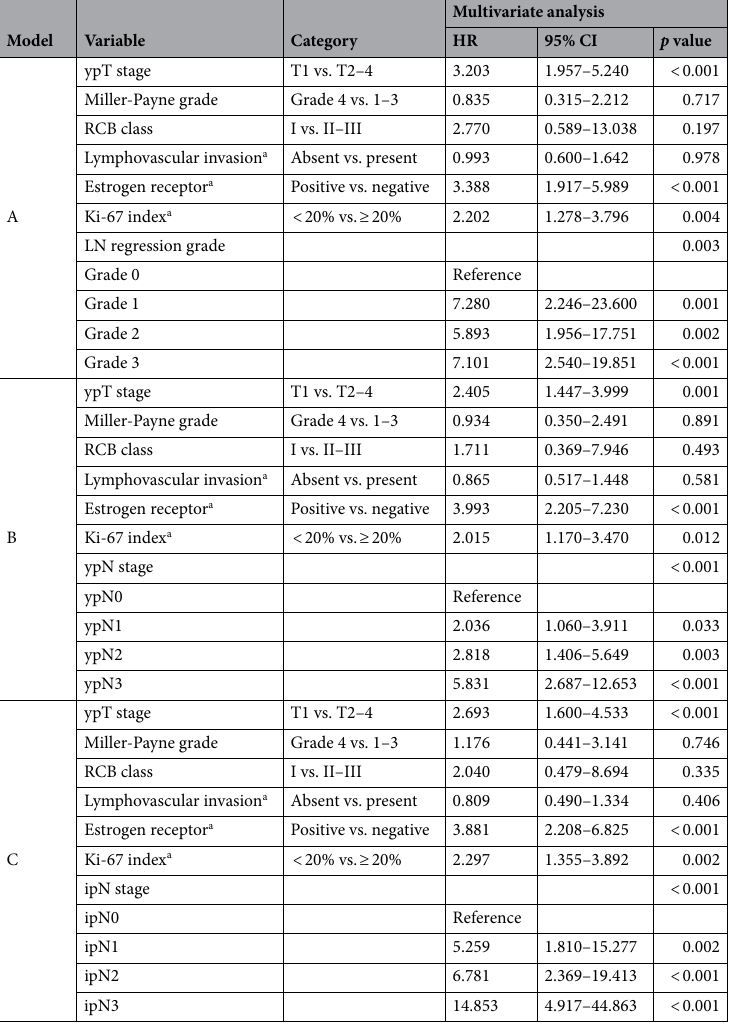
Table 5. Multivariate analyses of disease-free survival in the patient group with residual breast disease. HR hazard ratio, CI confidence interval, RCB residual cancer burden, ipN stage initial pathologic N stage. a post- NAC